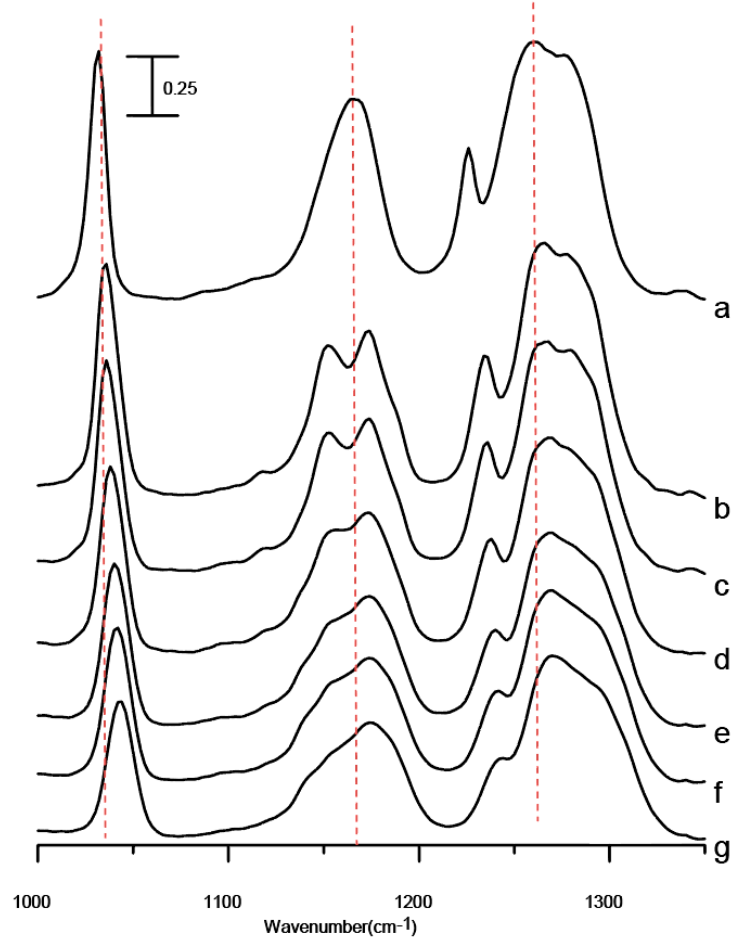
Figure 4. IR spectra of the [BMIM][TFS]/Al 2 O 3 mixture obtained under ambient pressure (curve a) and at 0.4 (curve b), 0.7 (curve c), 1.1 (curve d), 1.5 (curve e), 1.8 (curve f), and 2.5 GPa (curve g). Relative intensities of the IR bands are given in increments of 0.25; the scale bar is displayed in the upper left corner of the figure.